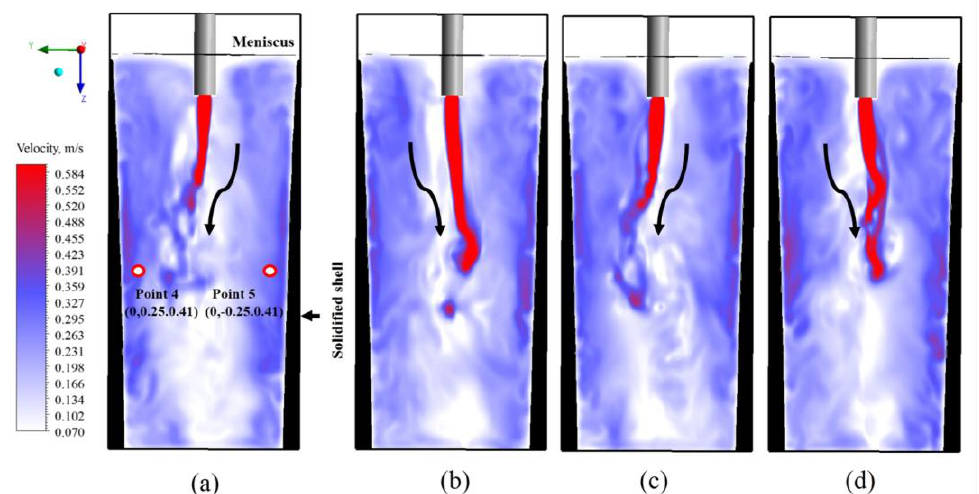
Figure 12. Evolution of asymmetrical flow pattern inside the mold, including two processes: left to right ( a to b ), right to left ( b to c ), and left to right ( c to d ).